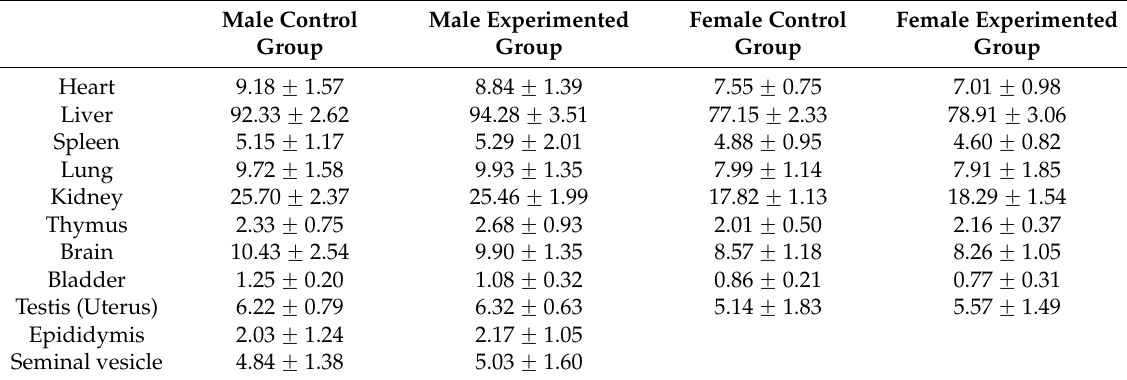
Table 2. Organ coefficient of mice in the acute toxicity test (mg/g).